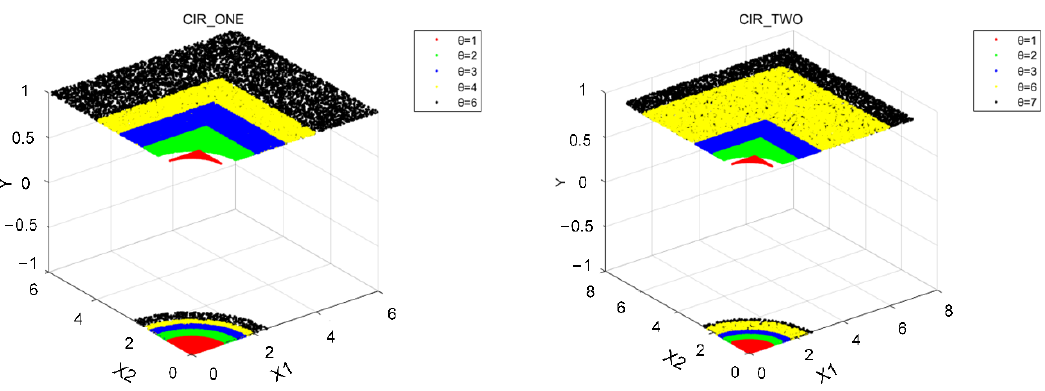
Figure 2. Concept distribution of CIR_ONE and CIR_TWO with different 𝜃.